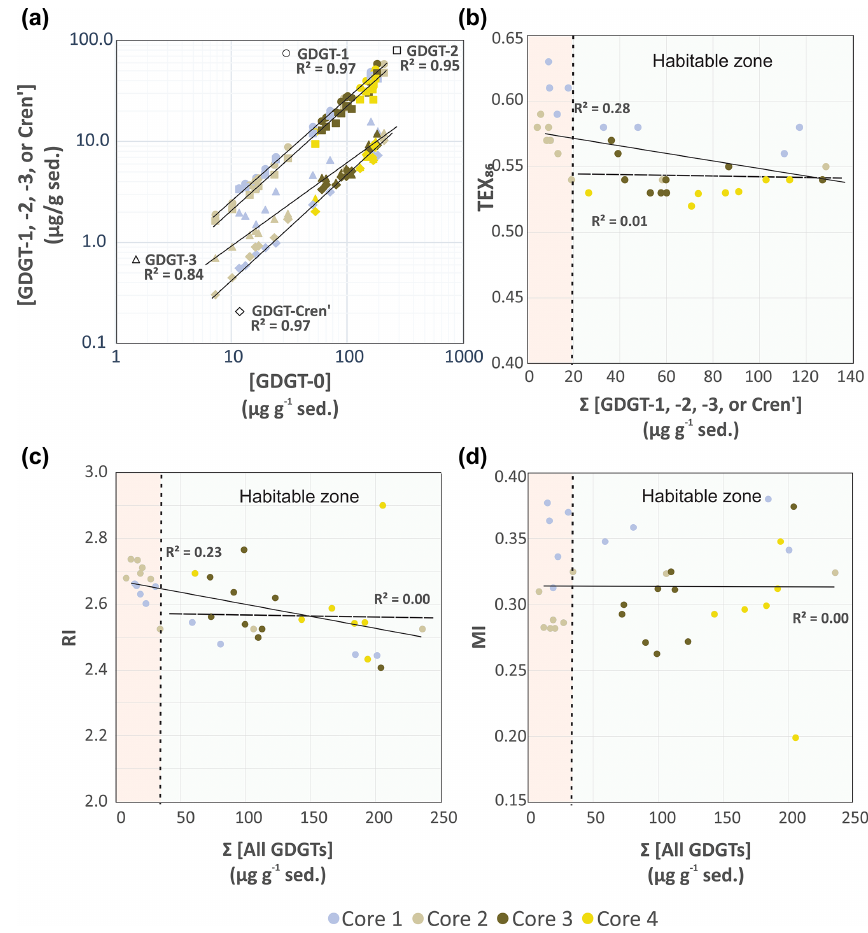
Figure 3. (a) Comparison of TEX 86 lipid concentrations GDGT-1 (circles), GDGT-2 (squares), GDGT-3 (triangles), and Cren’ (diamonds) relative to GDGT-0. Comparison of (b) TEX 86 , (c) RI, and (d) MI proxy values relative to summed iGDGT abundances of the Cathedral Hill transect cores. Light-green and pink regions indicate areas within and outside the habitable zone of life. Solid and dashed regression lines mark the total number of samples investigated for this study ( n = 34) and those that only reside within the habitable zone where up to 94% of the archaeal-lipid turnover occurs ( n = 22),